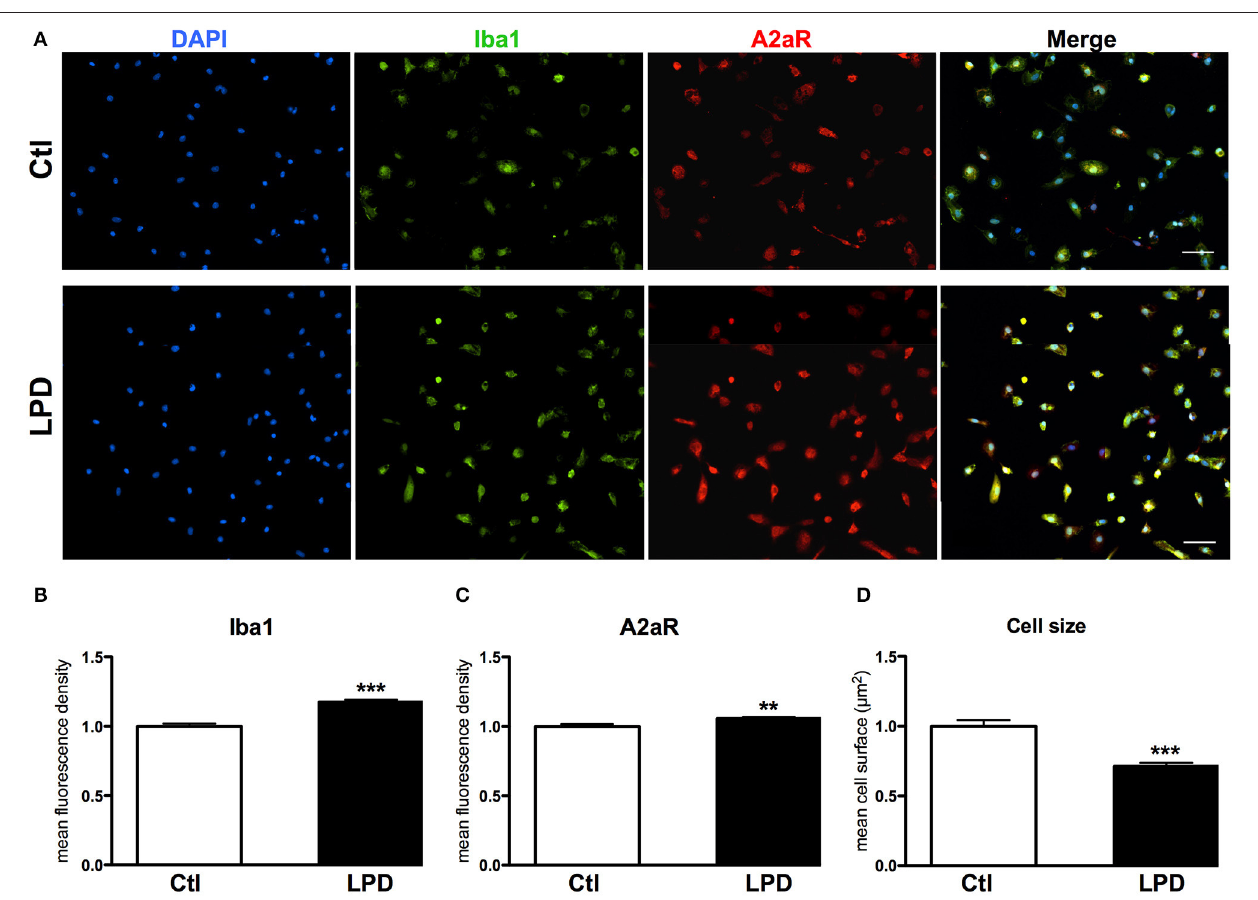
FIGURE 4 | A2aR expression in microglial cells sorted from animals exposed to LPD. (A) A2aR (red) and Iba-1 (green) immunoreactivity microglial cells sorted from LPD-exposed rat pups and control animals (scale bar: 50 µ m). (B,C) Quantification of mean fluorescence for A2aR and Iba-1 immunoreactivity in control and LPD microglial sorted cells. (D) Quantification of cell size on Iba-1 positive cells. Data are shown as relative expression of control values normalized to 1 (** p < 0.01, *** p < 0.001, using unpaired Student’s t